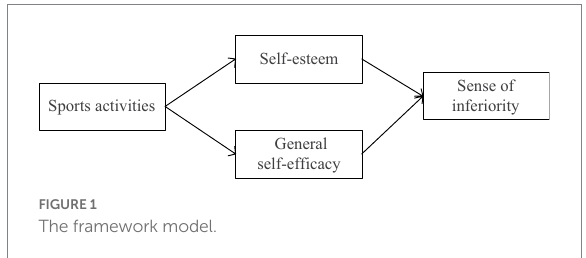
TABLE 1 Basic information of the research